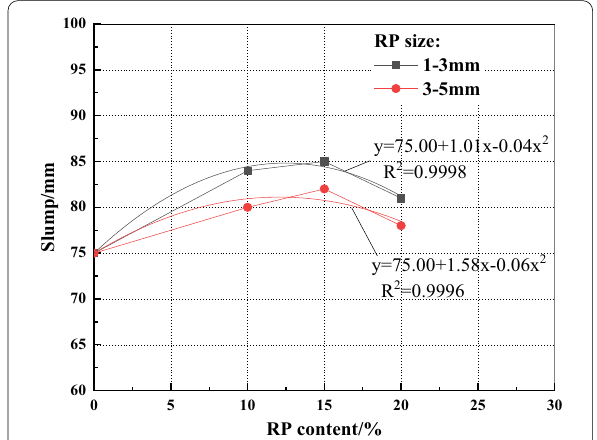
Fig. 5 Relationship between the slump of the group A concrete mixture and RP